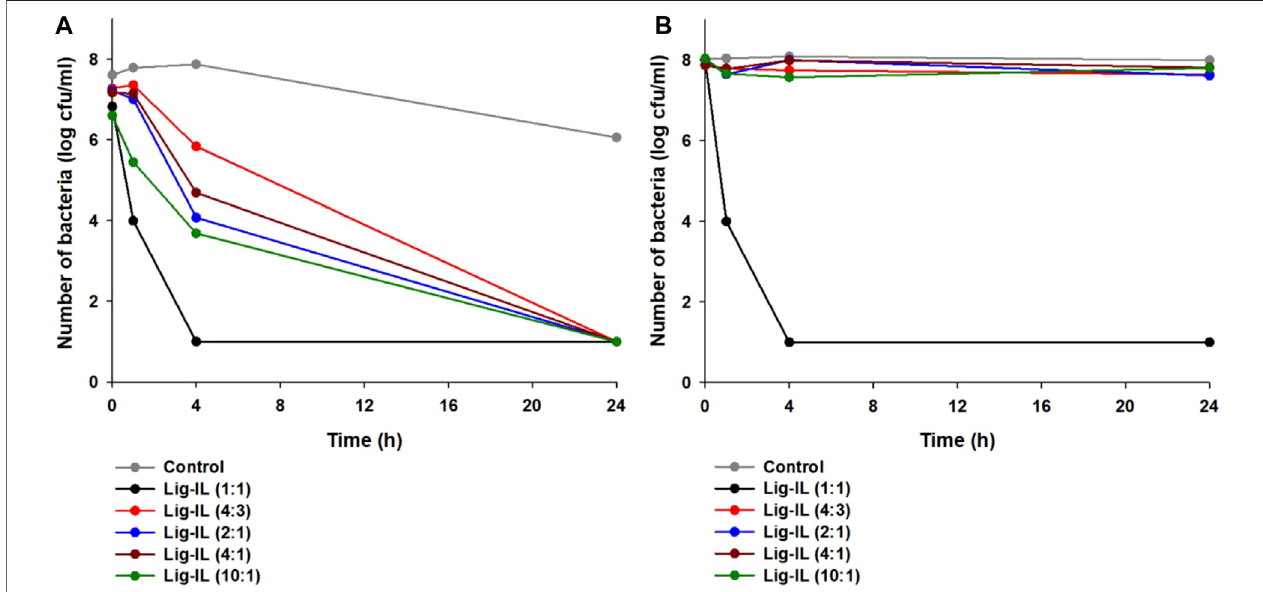
FIGURE 6 | Antibacterial activity of examined materials against Staphylococcus aureus (A) and Escherichia coli (B) .